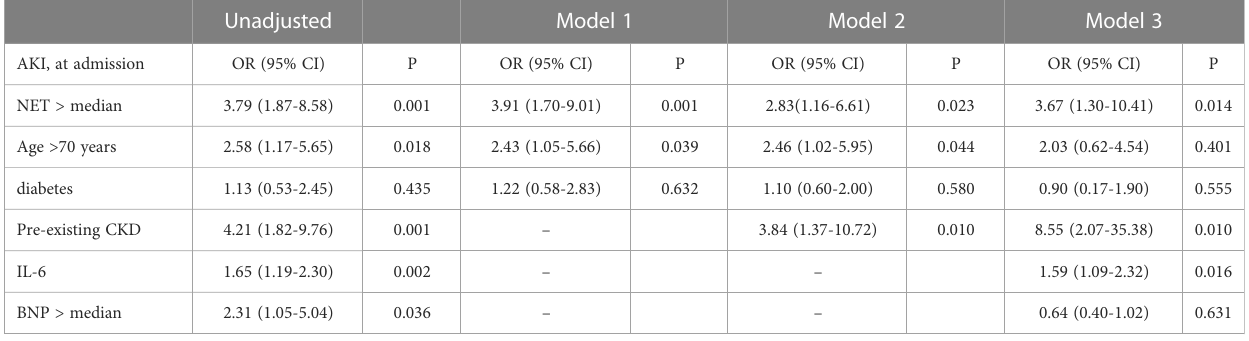
TABLE 4 Risk of AKI in association with high NET level.